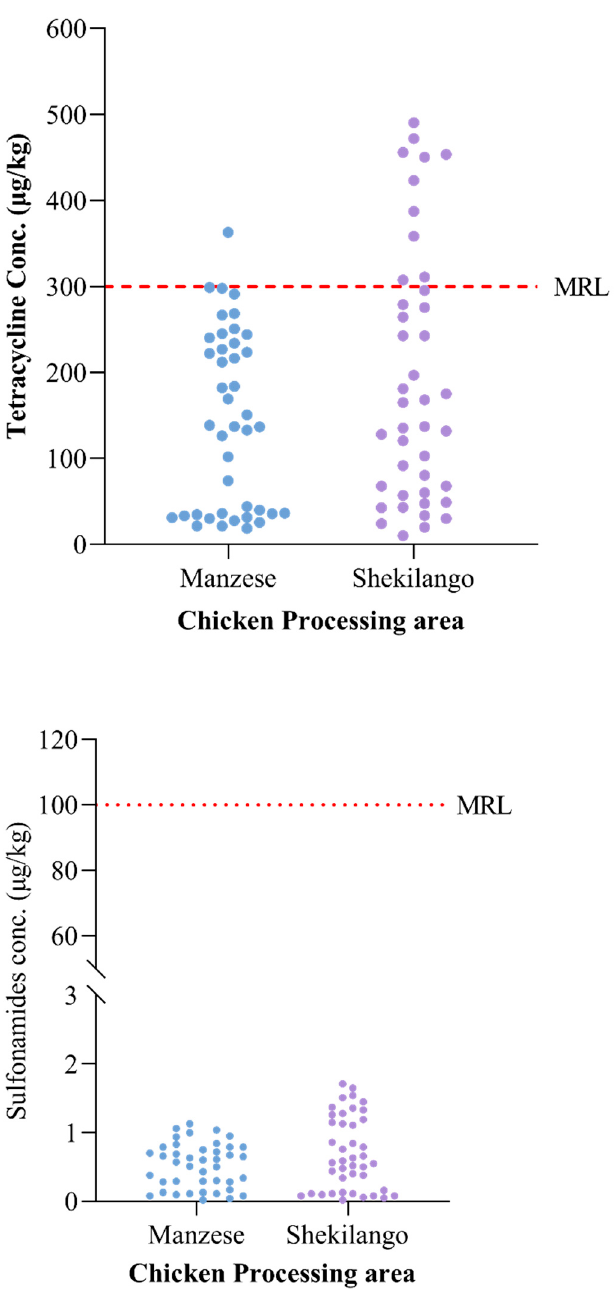
Figure 2. Maximum residue limit cut-off points for tetracycline and sulphonamide residues in chicken liver tissue samples.